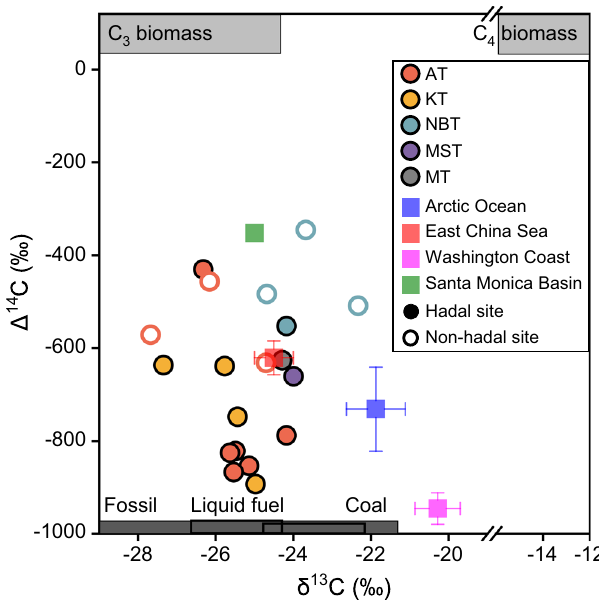
Fig. 5 Cross-plot of stable carbon isotopic composition ( δ 13 C) and radioactive carbon isotopic composition ( Δ 14 C) for the Black carbon (BC) in sediments. The data are from trench regions (this study) and Arctic Ocean 11 , East China Sea 12 , Washington coast (North Paci fi c Ocean) 42 , and Santa Monica Basin (North Paci fi c Ocean) 43 . Error bars denote standard deviation.